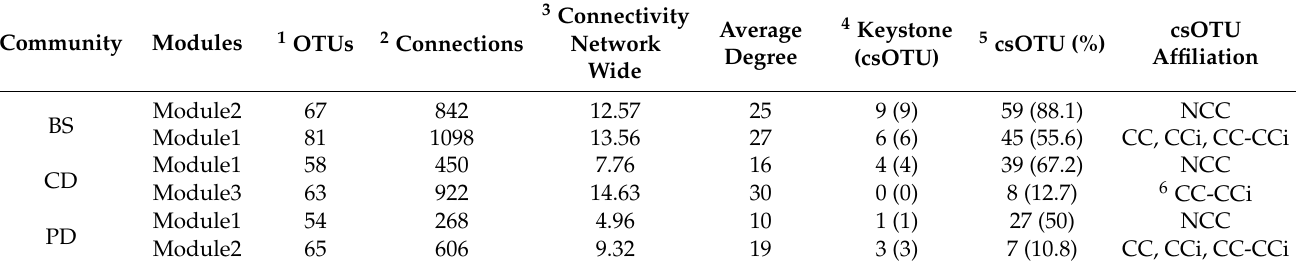
Table 2. Properties of fungal co-occurrence networks.